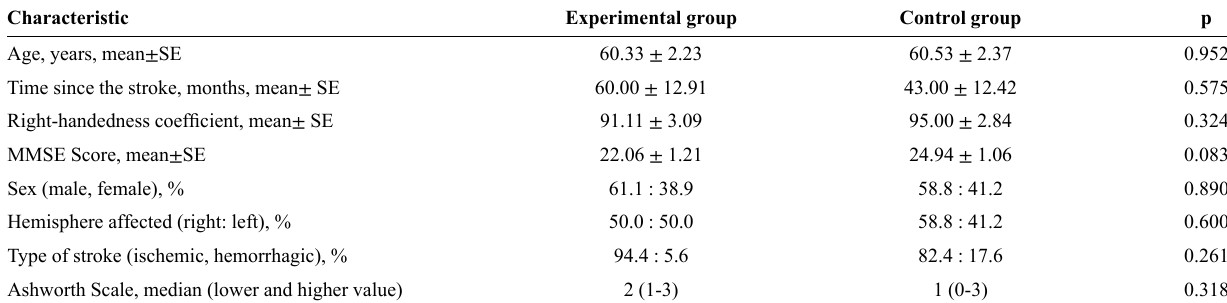
Table 1 - Participants' characteristics Characteristic